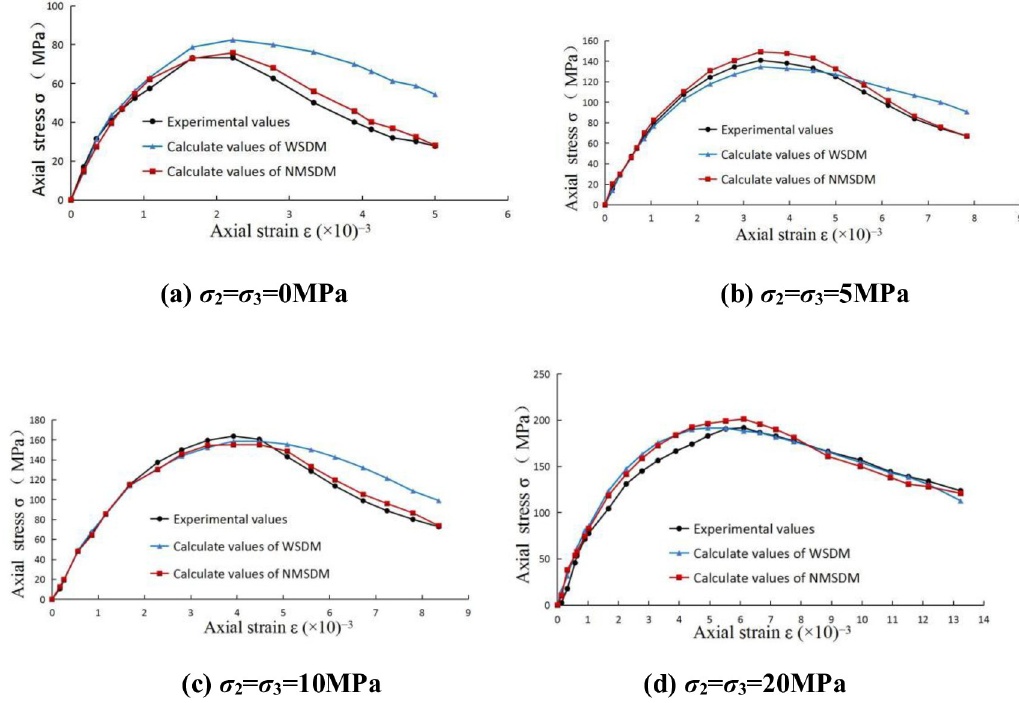
Fig 3. Comparison of experimental and calculated values for sandstone: (a) σ 2 = σ 3 = 0MPa; (b) σ 2 = σ 3 = 5MPa; (c) σ 2 = σ 3 = 10MPa; (d) σ 2 = σ 3 = 20MPa.